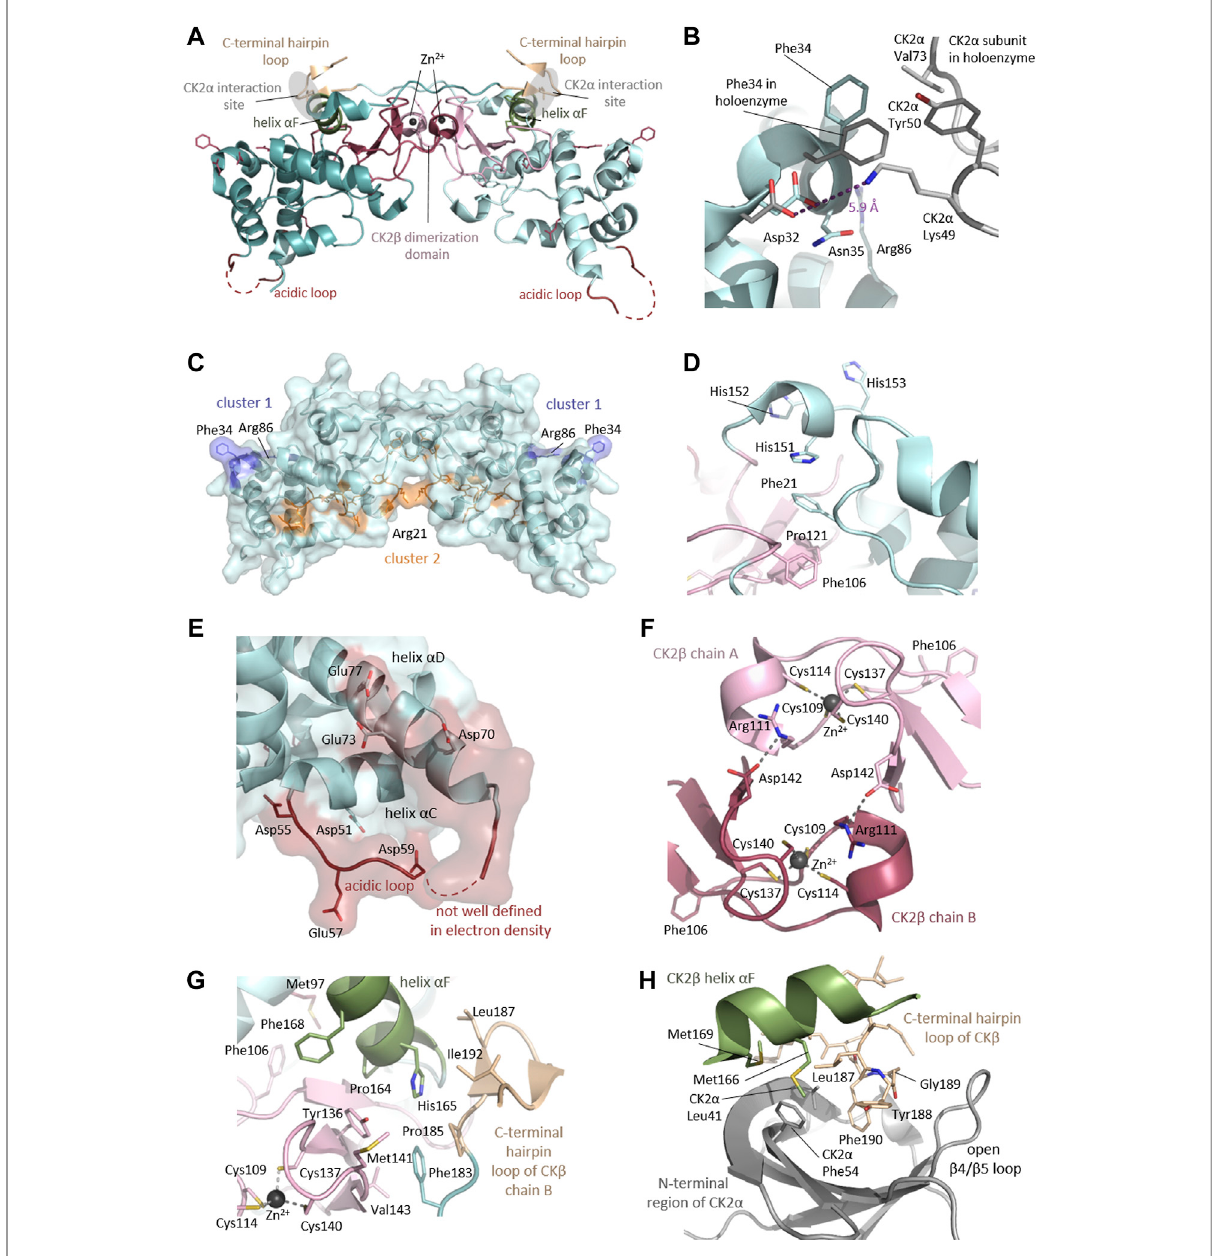
FIGURE 7 Detailed CK2 β functional and structural domains. (A) Clustering of mutation sites in structural and functional key elements of the CK2 β dimer. The mutated residue side chains are shown as sticks and are coloured according to the different elements as described in the fi gure. Mutation sites residing outside of the highlighted elements are shown in raspberry red. The CK2 β 1-193 structure (PDB_ID: 3EED (Raaf et al., 2008)) was used for the fi gure.PartsofchainAoftheCK2 β 1-193 dimer,whicharenotbelongingtothehighlightedelements, aredrawninlightcyanandthedimerization domain is drawn in light pink. Analogously, parts of chain B are drawn in dark cyan and the dimerization domain is drawn in raspberry red. The acidic loops were not de fi ned by electron density and are therefore indicated as dashed lines. (B) Mutation sites in the N-terminal region forming a conservedsurfaceexposedcluster.ThestructureoftheCK2 β 1-193 dimer(PDB_ID:3EED(Raafetal.,2008))isdrawninlightcyanandthestructuresof the CK2 β and CK2 α subunit assembled in the CK2 holoenzyme (PDB_ID: 4DGL (Lolli et al., 2012)) are drawn in grey. The CK2 β mutation sites Asp32, Phe34, Asn35 and Arg86 are drawn as sticks, as well as CK2 α residues, which are located near the CK2 β mutation sites in the assembled CK2 holoenzyme. The distance between CK2 β Asp32 and CK2 α Lys49 is shown as a purple dashed line to illustrate that the distance is too far to establishaclosecontactviaasaltbridge. (C) ConservedsurfaceclustersasdescribedbyChantalat(Chantalatetal.,1999).The fi rstconservedsurface exposed cluster is composed of Asp32, Phe34, Asn35 and Arg86 (drawn in blue). The second surface cluster is composed of: Ile10, Glu20, Phe21, Phe22, Cys23,Glu24,Lys100,Asp105,Gly107, Pro110,Tyr144,Pro146,Lys147and Ser148(drawninorange).The sidechainsofresiduesIle10,Cys23, Phe21, Phe22, Pro146 and Tyr144 point into the inside of the protein. The mutation site Phe21 is highlighted. (D) Environment of the Chantalat ’